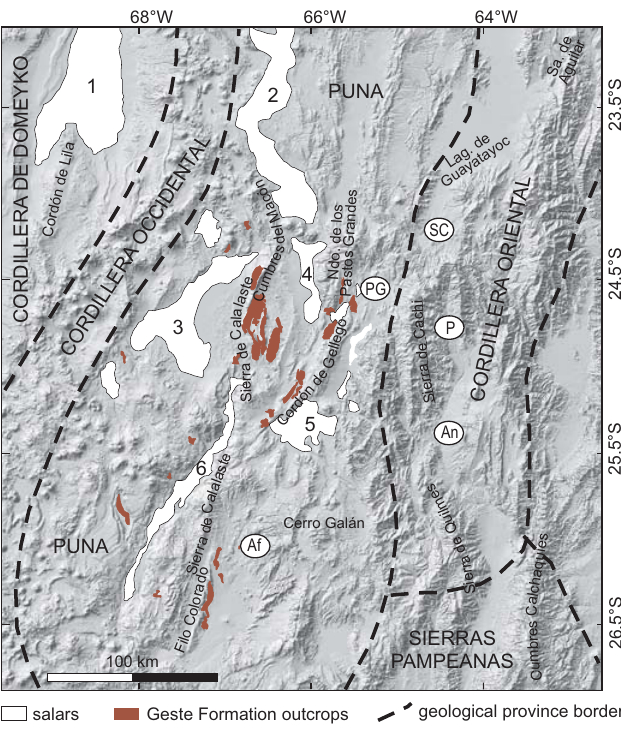
Fig. 2. Distribution of Geste Formation in different basins of the Northwestern Argentina. The distribution of this formation is mainly along N-S areas close to the Eastern margin of the Puna Plateau, coinciding with the predomi- nant Andean direction. 1, Salar de Atacama; 2, Salar del Rincón; 3, Salar de Arizaro; 4, Salar de Pocitos; 5, Salar del Hombre Muerto; 6, Salar de Antofalla; SC, San Antonio de los Cobres; PG, Santa Rosa de los Pastos Grandes; P, La Poma; An, Angasto; Af, Antofagasta de la